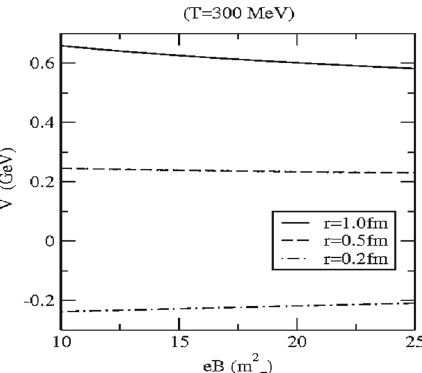
Fig. 5 Effect of the magnetic field on short- and long-range behavior of the potential